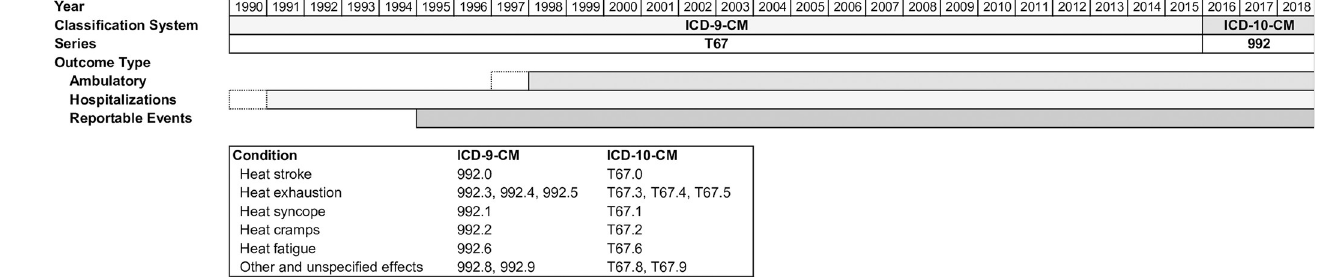
Fig 1. Clinical classification codes and included outcome types by year. The shaded bars depict the included years for each outcome type.